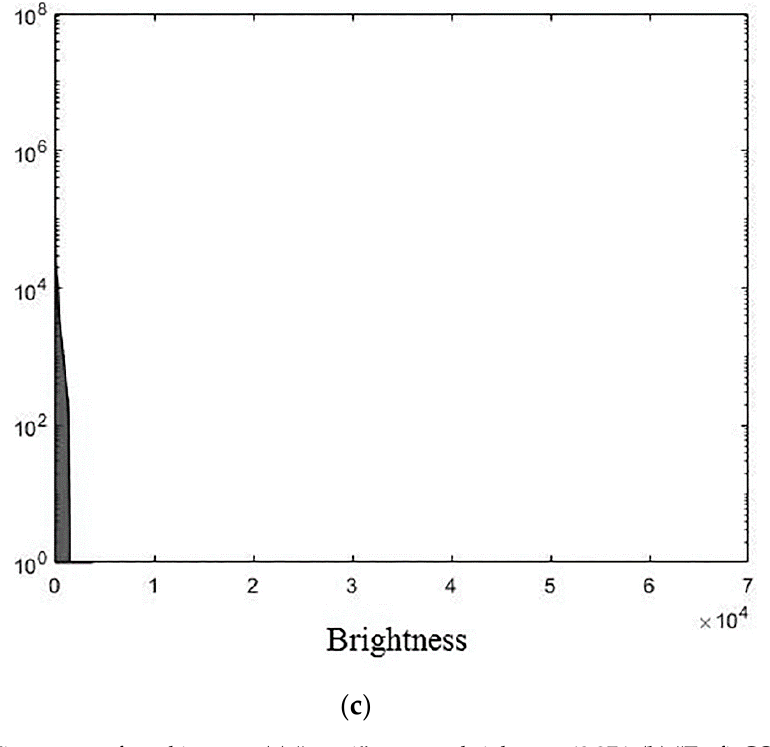
Figure 4. Histograms of used images: ( a ) “wmri”, average brightness 63.276; ( b ) “Trufi_COR”, average brightness 129.796 and ( c ) “Body_1.0”, average brightness 21.053. Appl. Sci. 2020 , 10 , 1223